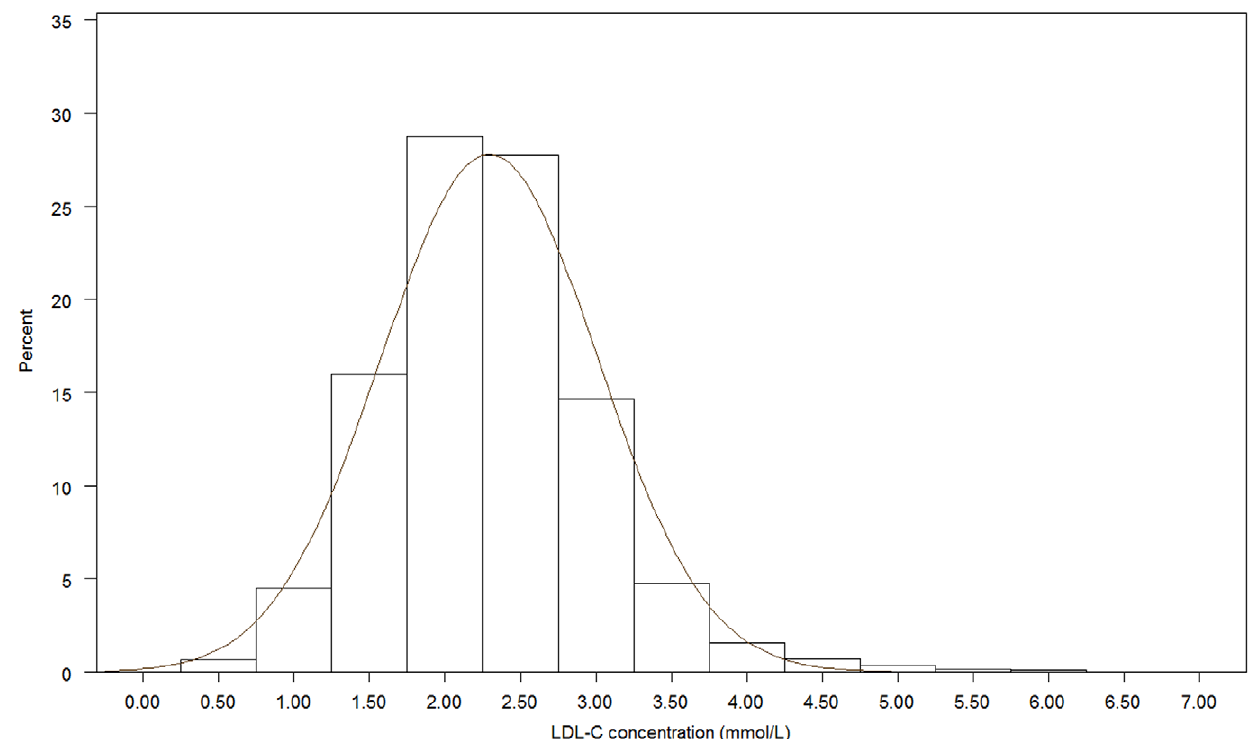
Figure 2. Histogram for the LDL-C values in patients on atorvastatin.